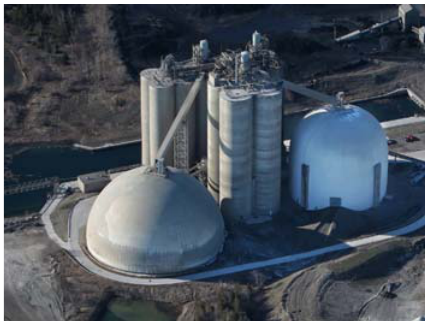
Figure 18: Rotationally symmetric concrete dome built by Dome Technology [21] © Dome